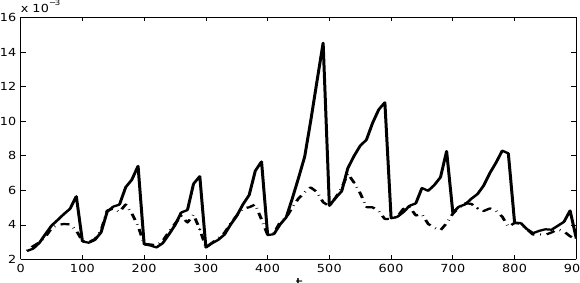
Figure 7. Full line: mean square error between ground truth vor- Fig. 7: Full line: mean square error between ground truth vorticity and estimated filtering mean; Dotted line: ticity and estimated filtering mean; dotted line: mean square error mean square error between ground truth vorticity and estimated backward smoothing mean. between ground truth vorticity and estimated backward smoothing